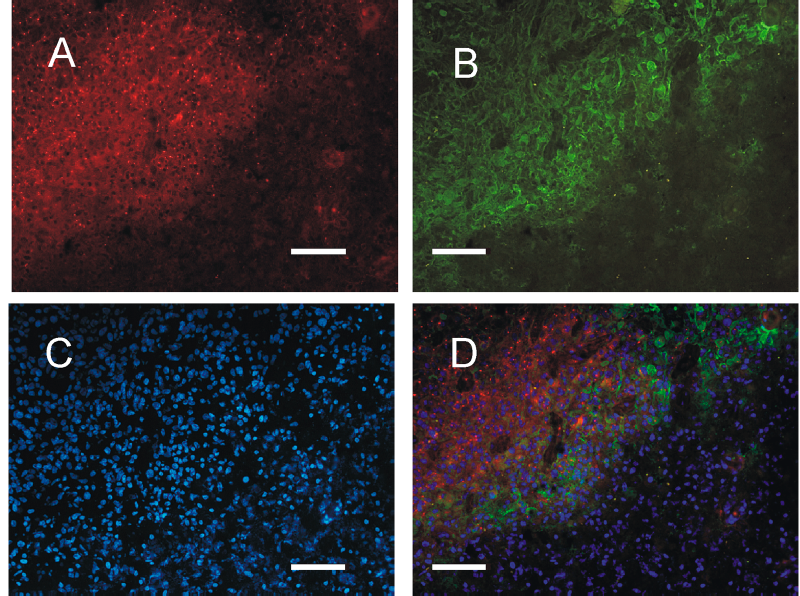
Figure 6. Representative distribution of PKA regulatory subunit R2 in a glioblastoma sample (case